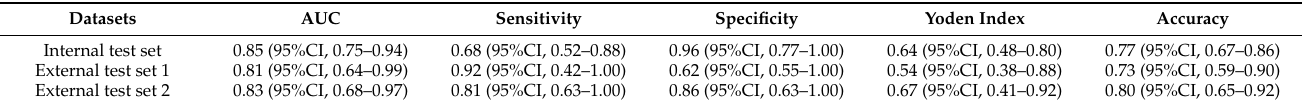
Figure 4. ROC curve of logistic regression model for predicting the prognosis of patients with sICH after surgery in three test sets. a: internal test set; b: external test set 1; c: external test set 2. Table 4. Performance of logistic regression model in multicenter